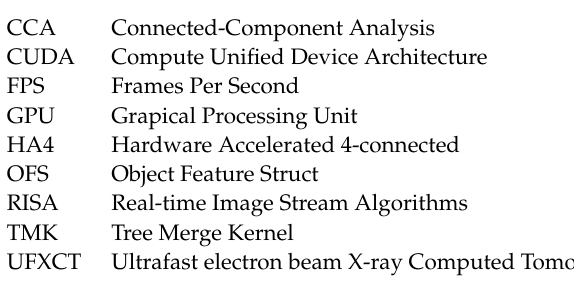
Figure 4. For analysis of 256px images, only the top-left 256 × 256 px region was used. The subset “random/classical“ was used for Figures 5 and